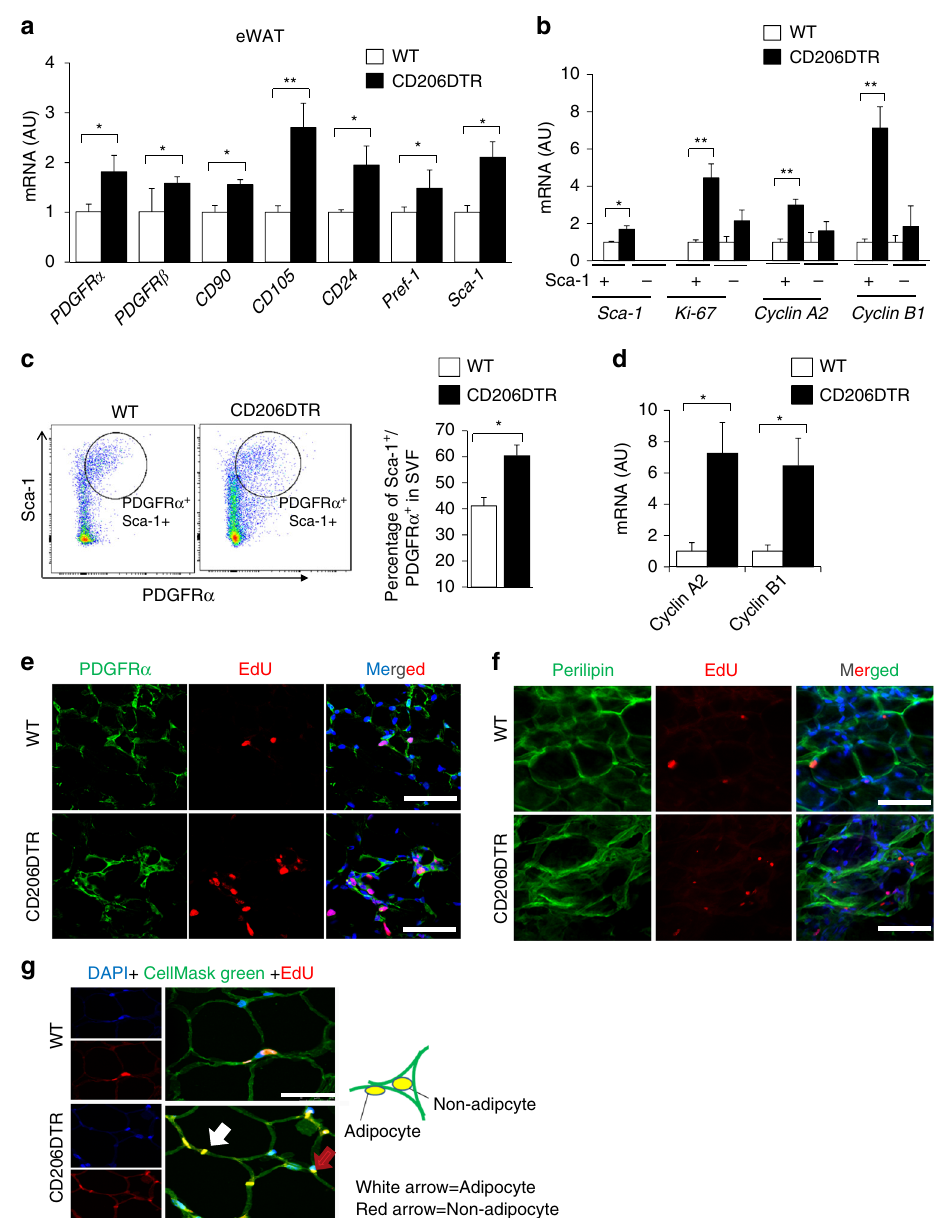
Fig. 3 Effects of CD206 + M2-like macrophages depletion on cell proliferation. a Relative mRNA expression of mesenchymal stem cell (MSC) and AP markers in the eWAT ( n = 4 – 6 mice per group). b Relative mRNA expression of MACS puri fi ed Sca-1 positive fraction ( n = 3 mice per group). c Representative fl ow cytometry analysis of Sca-1/PDGFR α double positive cells in the SVF of eWAT from DT-treated WT and CD206DTR